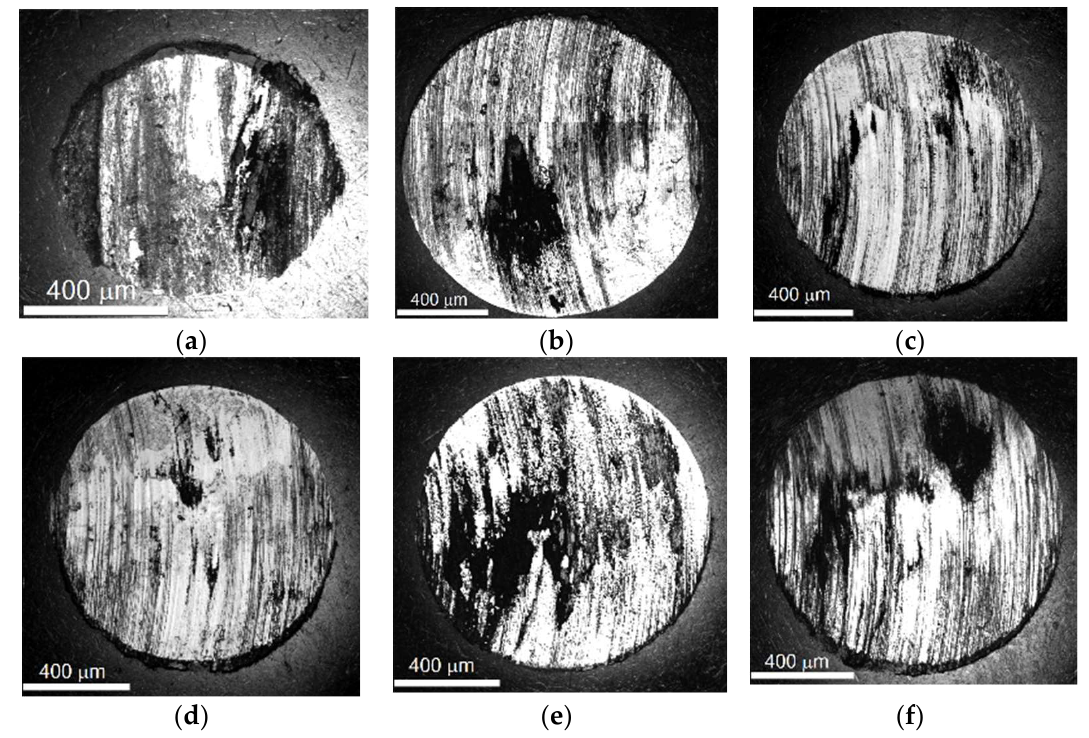
Figure 10. Optical images of wear scars on steel balls rubbed against ZrN ( a ), CrN ( b ), ZrCrN(0.5) ( c ), ZrCrN(3.5) ( d ), ZrCrN(5) ( e ) and ZrCrN(8) ( f ) coatings at 6 Н.